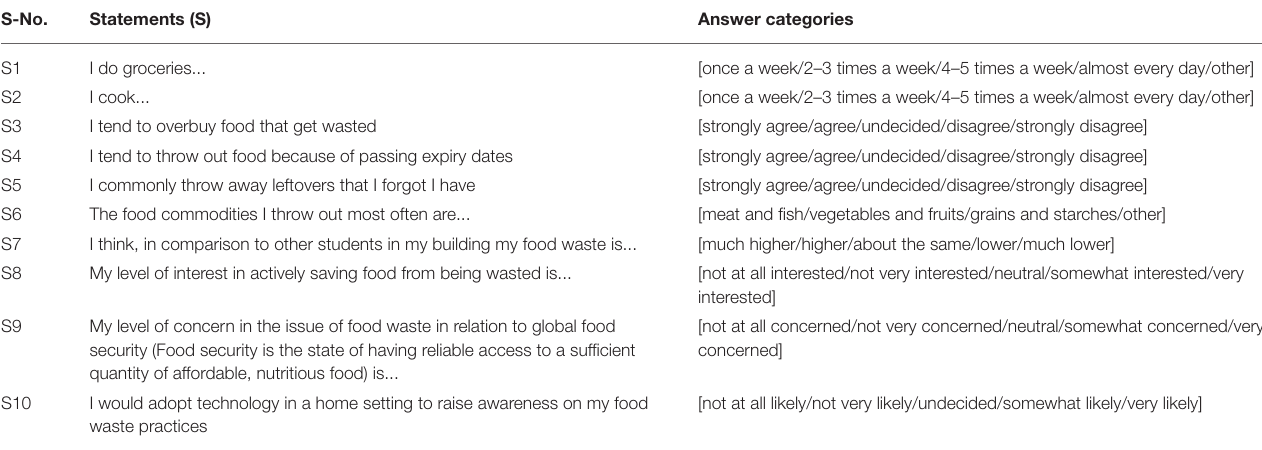
TABLE 1 | Online questionnaire with 10 items (S1–S10) provided to all residents in this study.